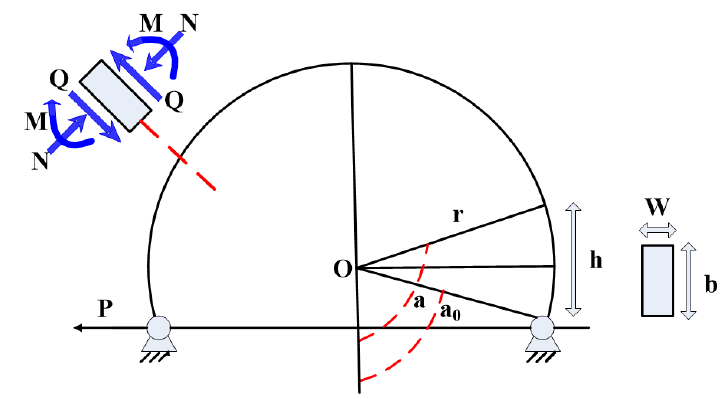
Figure 2. Mechanism diagram of the energy absorption device.